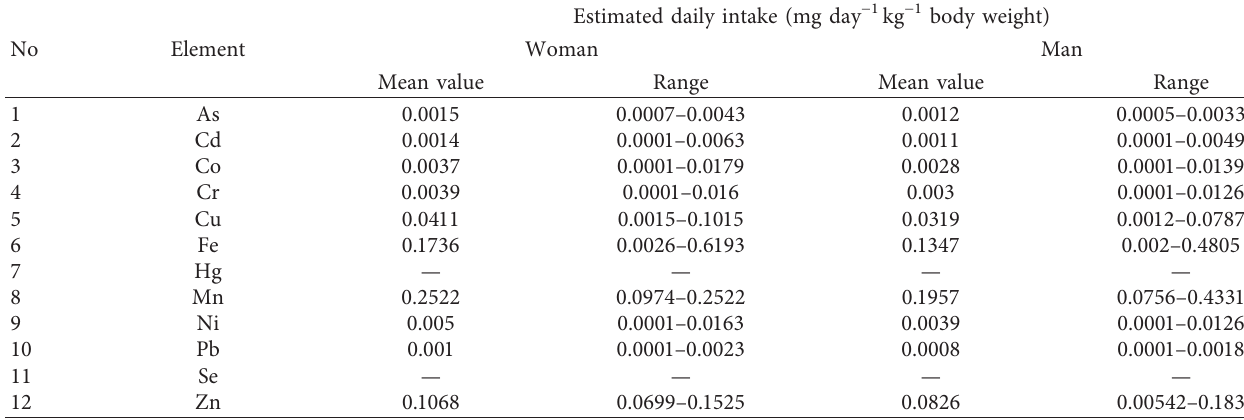
Table 3: Estimated daily intake of arsenic and heavy metals through rice